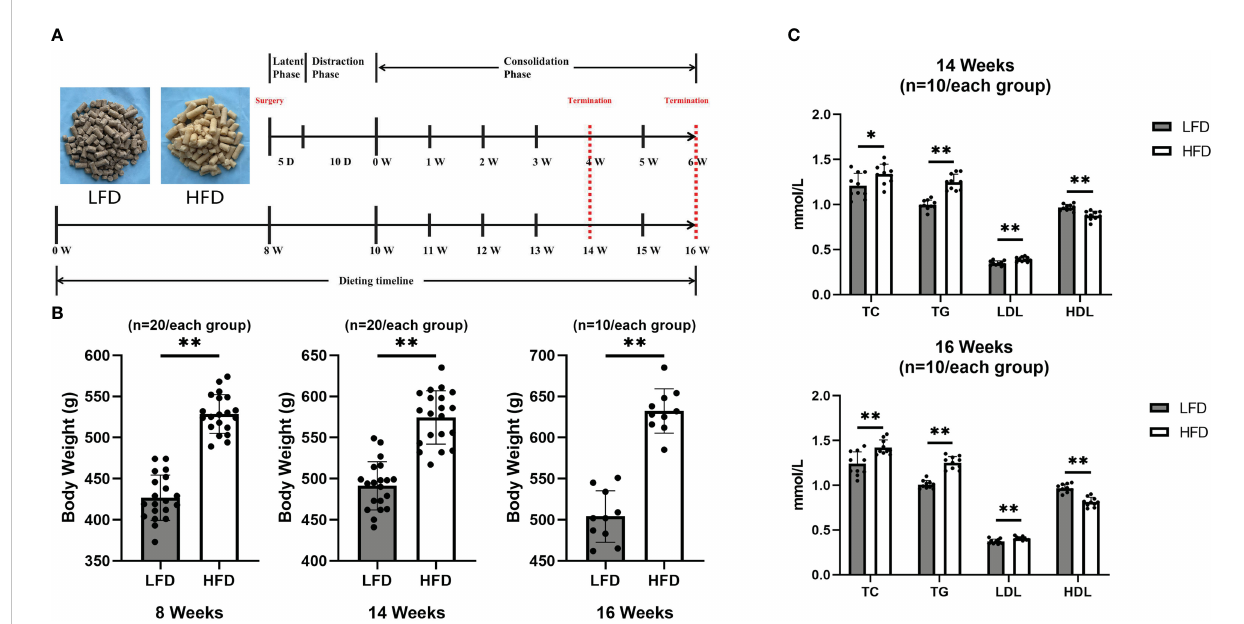
FIGURE 1 HFD-induced obese rats. (A) Dietary and surgical observation timeline. (B) Body weight values were higher in the HFD group at 8, 14, and 16 weeks than in the LFD group. (C) At 14 and 16 weeks of feeding, quantitative evaluations showed that TC, TG, and LDL levels in HFD were signi fi cantly higher than those in LFD while HDL levels were higher in LFD group. (*P<0.05,